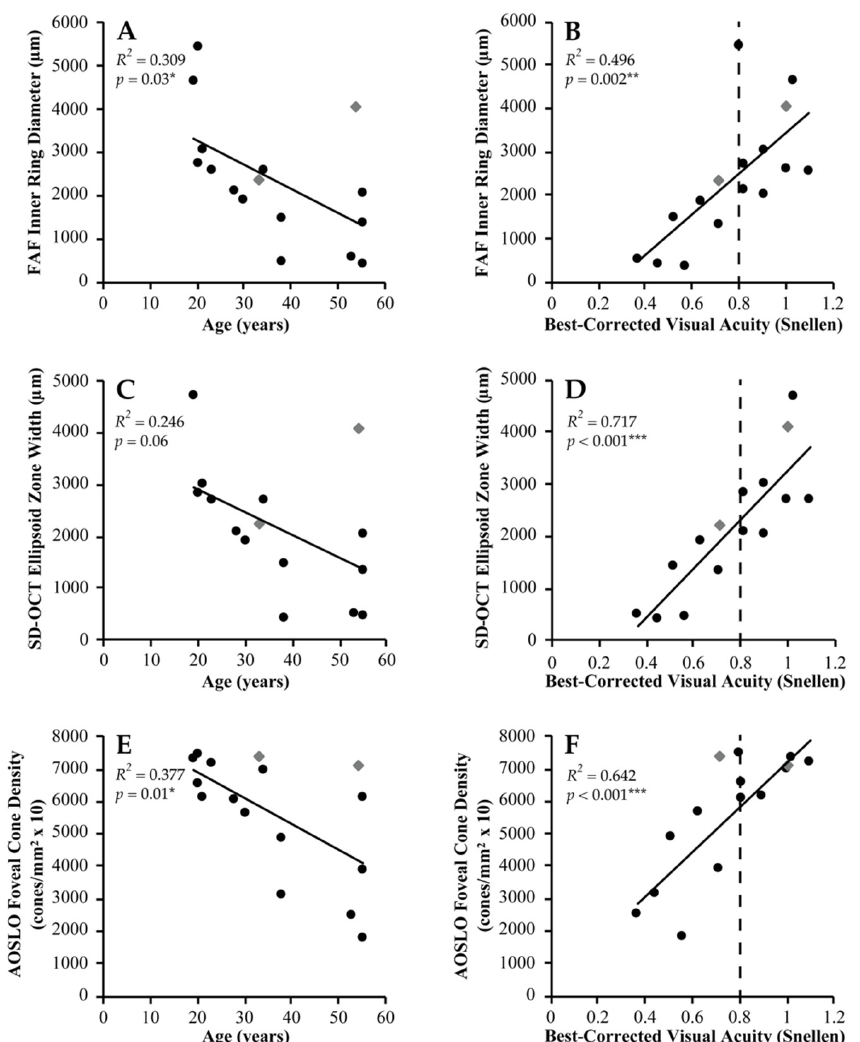
Figure 1. Age and functional correlation of retinal imaging in USH2A retinopathy. Scatterplots of retinal imaging metrics in association with ( A , C , E ) age and ( B , D , F ) best-corrected visual acuity (BCVA) in USH2A -associated Usher syndrome (black circles) and non-syndromic retinitis pigmentosa (grey diamonds) are shown. ( A , B ) Fundus autofluorescence (FAF) inner ring diameter ( n = 16), ( C , D ) spectral-domain optical coherence tomography (SD-OCT) ellipsoid zone width ( n = 15), and ( E , F ) adaptive optics scanning laser ophthalmoscopy (AOSLO) foveal cone density ( n = 16) display the strongest correlations with age and visual function in their respective modalities. BCVA is presented in Snellen decimal format with normal defined as ≥ 0.80 (6/7.5) (dashed black line). A line of best fit (solid black line) is shown in each graph. R 2 and p -values for each correlation are shown, with asterisks denoting the degree of statistical significance.